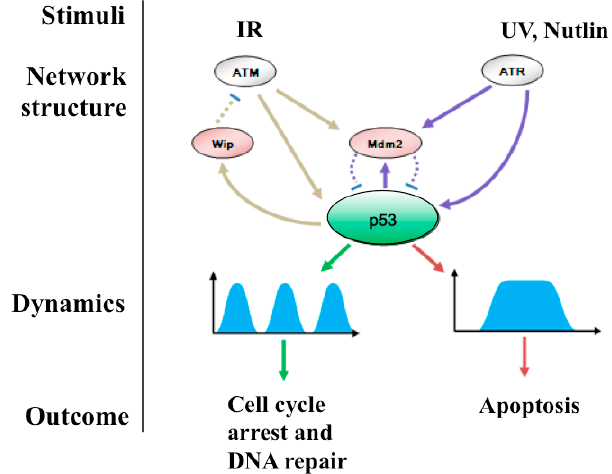
Figure 3. Activation of p53 governs the patterns of p53 dynamics. p53 can be activated by DNA double strand breaks (DSBs) induced by IR or single DNA strand breaks (SSBs) induced by UV radiation or nutlin. p53 can be activated by DSBs. This is mediated by the ATM ‐ p53 ‐ Wip loop negative feedback loop. Activation of p53 by SSBs is mediated by the ATR ‐ p53 ‐ Mdm2 negative feedback loop. These can subsequently lead to a series of transient pulses or a prolonged pulse, which in turn results in cell cycle arrest, cell recovery or apoptosis.